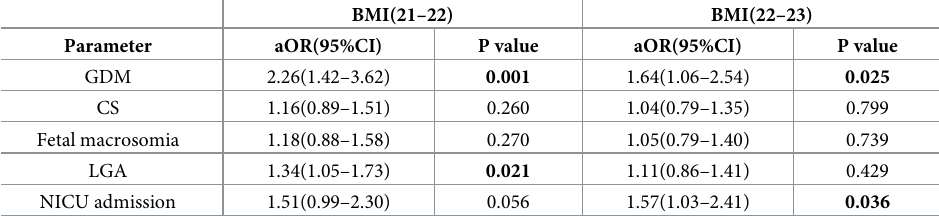
Table 10. Comparisons of adverse perinatal outcomes between target BMI group (BMI of 24–25) and BMI reduc- tion